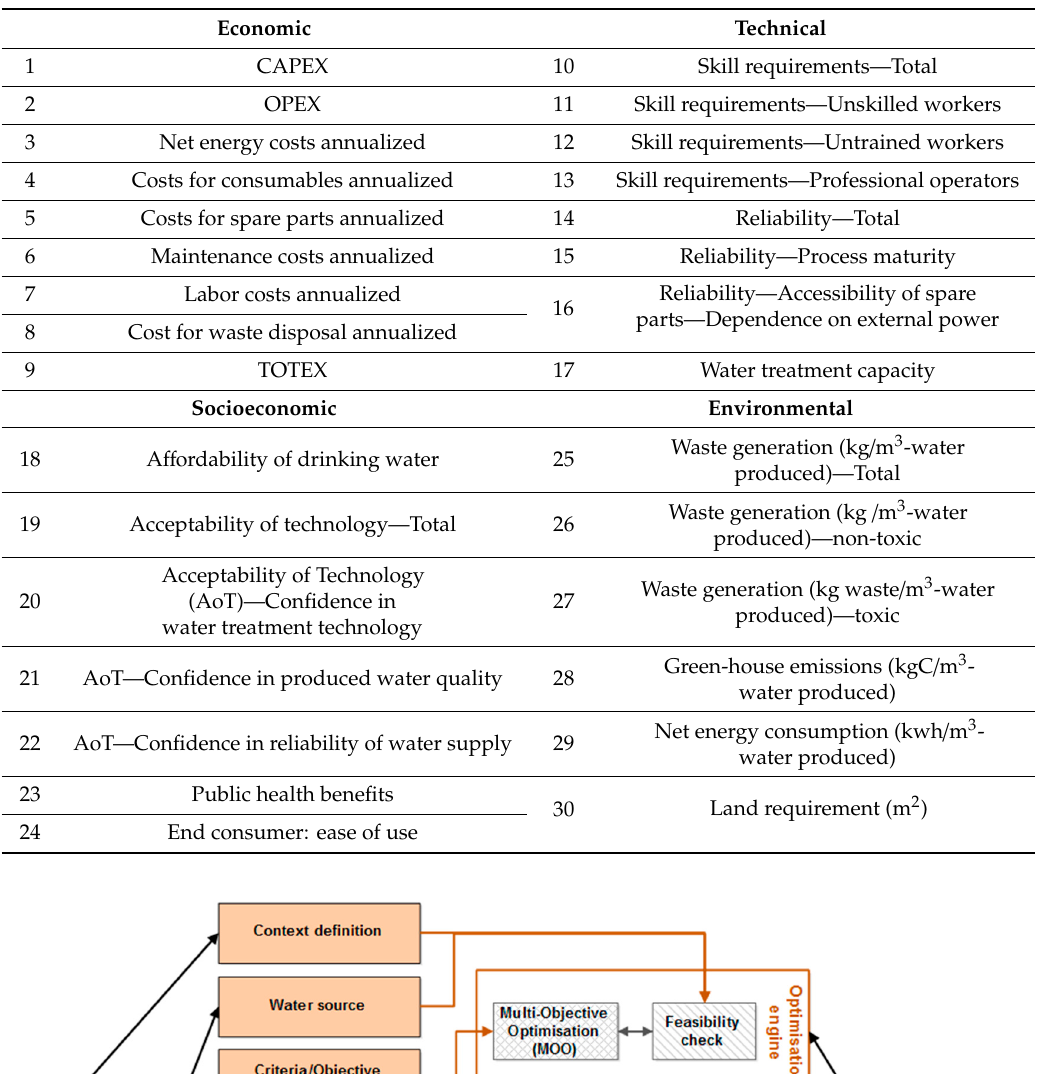
Table 1. The 30 criteria included in WETSUiT.